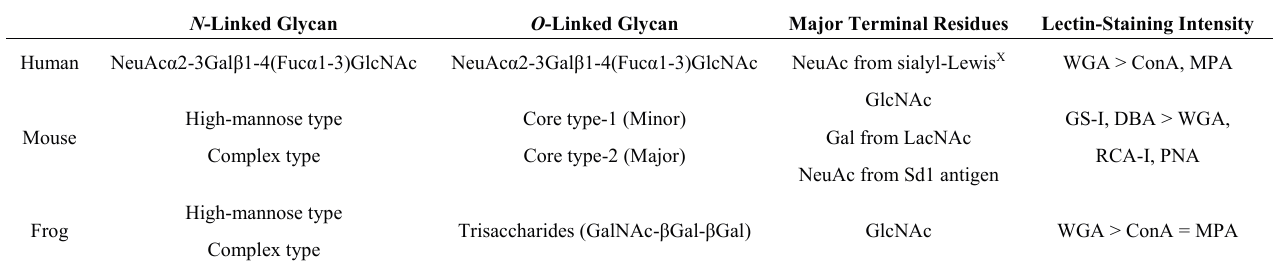
Table 1. Carbohydrates of the egg-coating envelope of human, mouse and frog. N -Linked Glycan O -Linked Glycan Major Terminal Residues Lectin-Staining